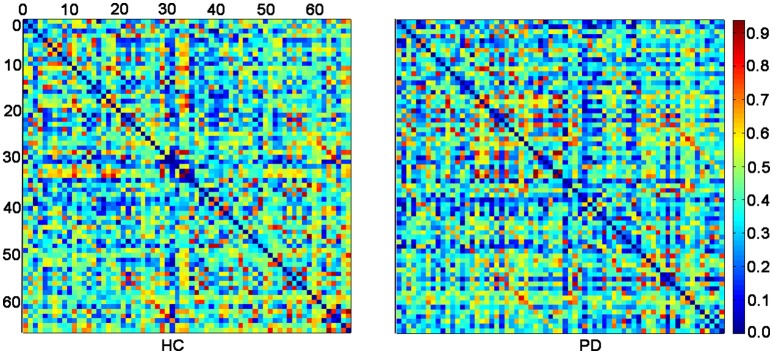
The inter-regional correlation matrices for HC and PD groups. The connectivity matrix shows the Pearson correlation coefficient between any two nodes of the network. The nodes are numbered according to Table 2 for better overview. The color bar represents the absolute value of the Pearson correlation coefficient, which ranged from 0 (blue) to 1 (red).